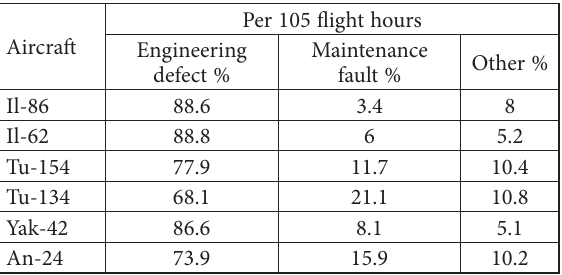
Table 2. Parity of incidents by basic reason and type of aircraft